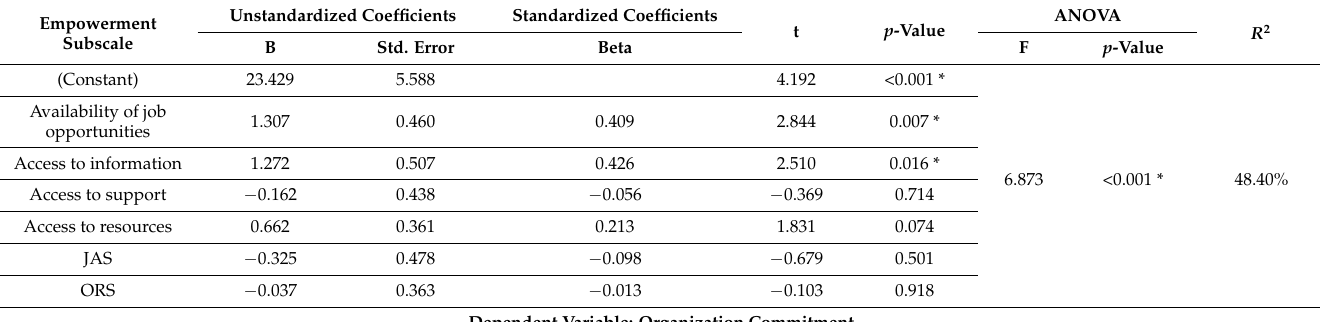
Table 8. The multivariate regression between Dependent Variable (Organization Commitment) and independents variables (Availability of job opportunities, Access to information, Access to support, Access to resources, JAS and